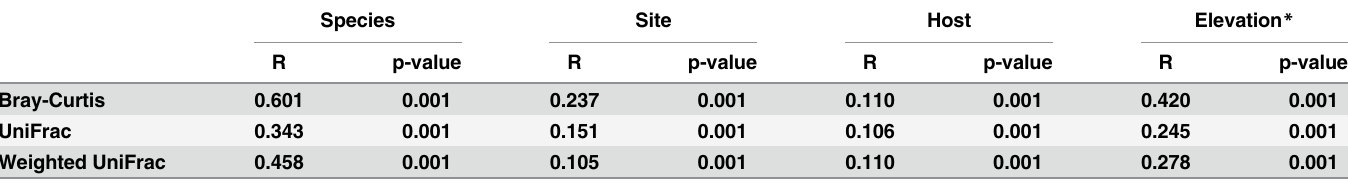
Table 4. Analysis of Similarity of bacterial communities (All Samples).